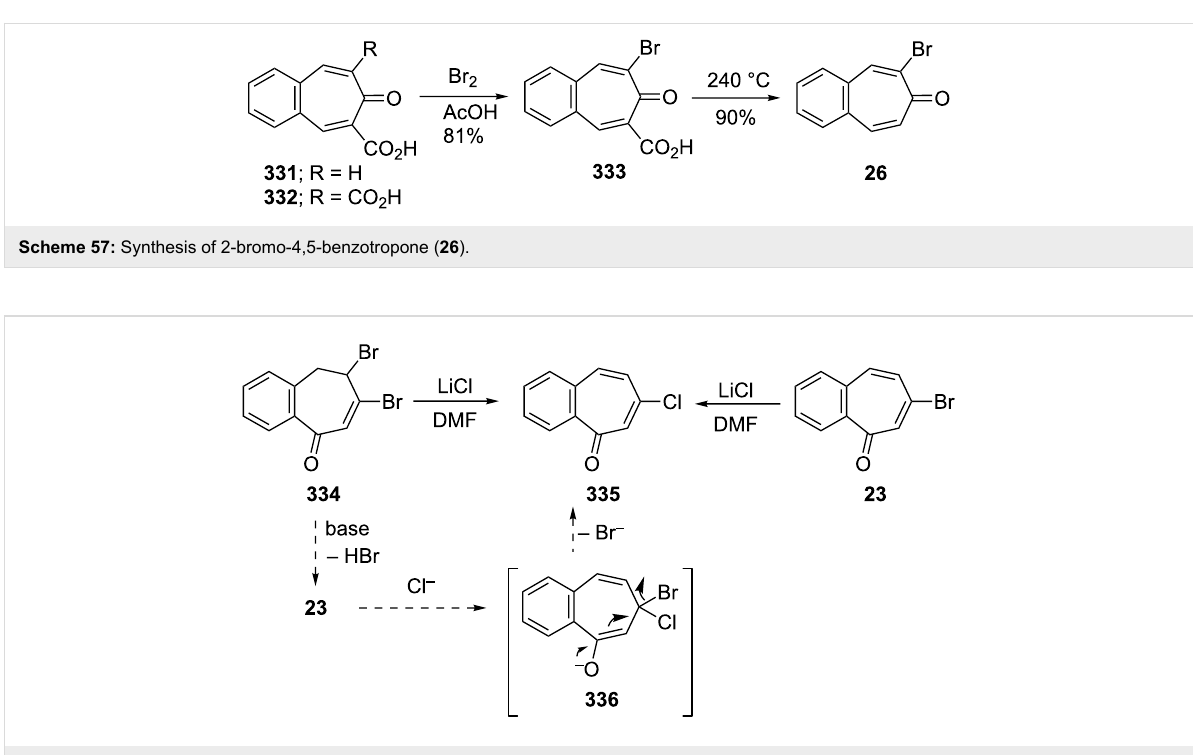
Scheme 58: Synthesis of 6-chloro-2,3-benzotropone ( 335 ) using LiCl and proposed intermediate 336 .